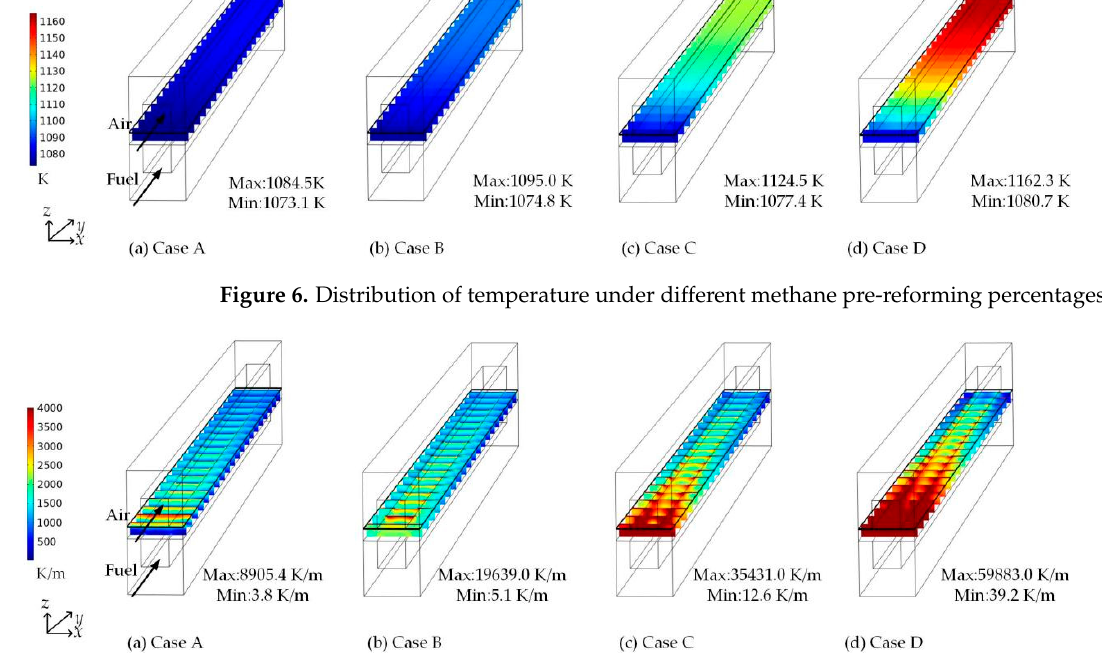
Figure 7. Distribution of temperature gradient under different methane pre-reforming percentages.